Question: In one sentence, what is this figure communicating?
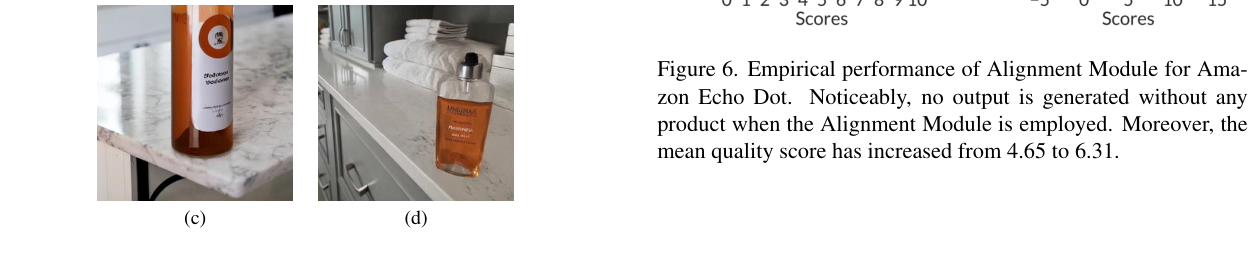
Answer: Inpainted product image of Paint-by-Example (PBE). PBE generates high-quality images which explains the higher CLIP score in the case of Lupure Vitamin C. However, the in- painted product does not look similar to the desired product at all resulting in very poor mean assigned quality and size scores. Out- put images for Amazon Echo Dot is shown in (a) and (b), and for Lupure Vitamin C is shown in (c) and (d).